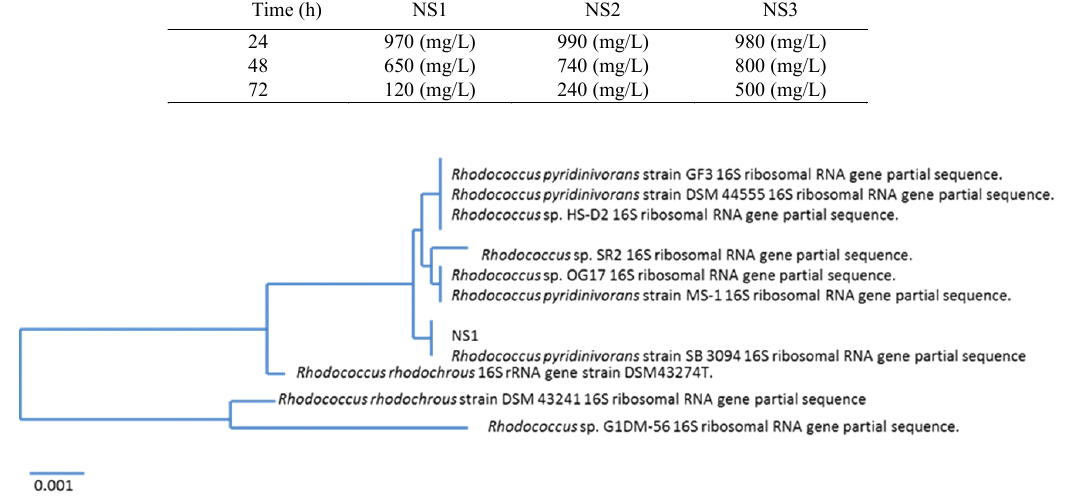
Fig. 1: Phylogenetic tree based on 16S rDNA gene sequence analysis showing the relationship between NS1strain and representative species of Rhodococcus genus